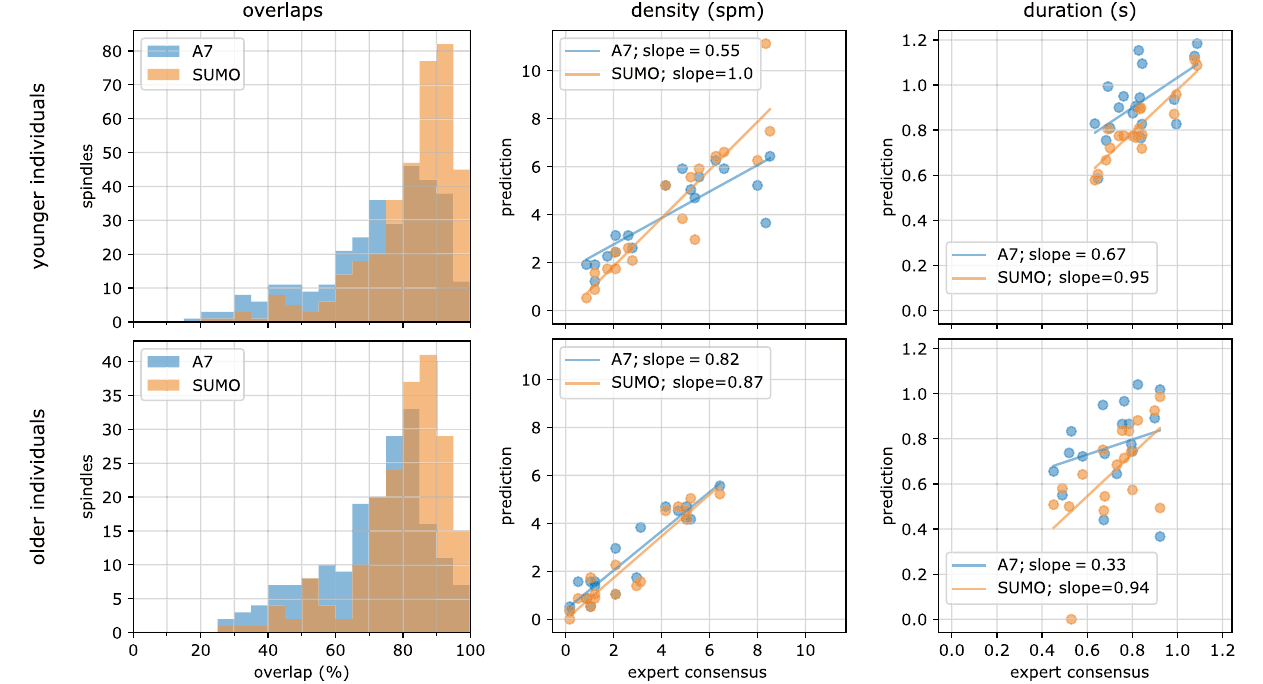
Figure 4. Overlap distribution, and spindle density and duration compared with expert consensus. Left panels: The frequency distribution of spindle predictions at specific overlaps computed for all spindles in the test set is more tightly peaked for SUMO (orange) compared with A7 (blue). The peak of the SUMO model is also shifted towards higher overlap percentages. Middle panels: Correlation analysis between per-individual spindle density from the expert consensus and predictions (SUMO, A7) indicate a flattened slope in younger individuals for A7 clearly deviating from 1. Right panels: Similarly comparing spindle durations, A7 also shows a flattened slope.